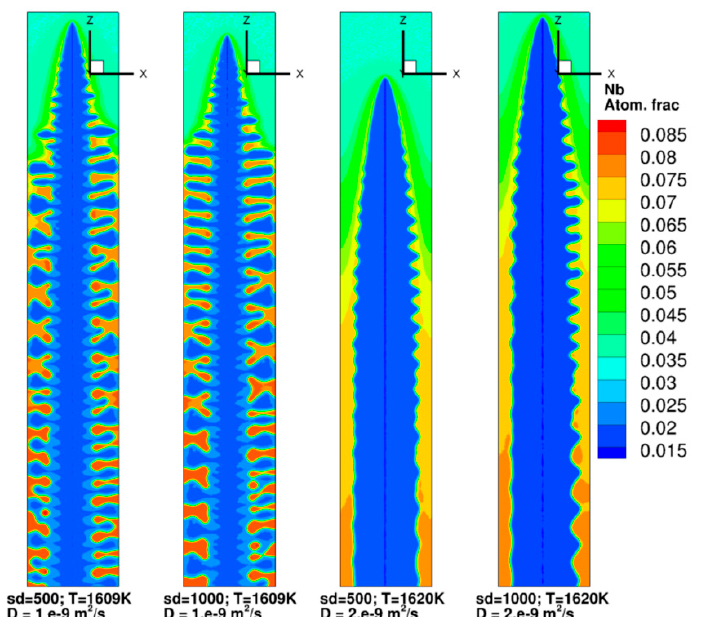
Figure 7. Dendrite morphologies obtained in 2D steady-state simulations with a temperature gradient of 2.6 × 10 6 K/m and a s-l interface velocity of 0.1 m/s. The single seed 2D simulations were extended to full 3D case. The growth kinetics are shown in Figure 8.